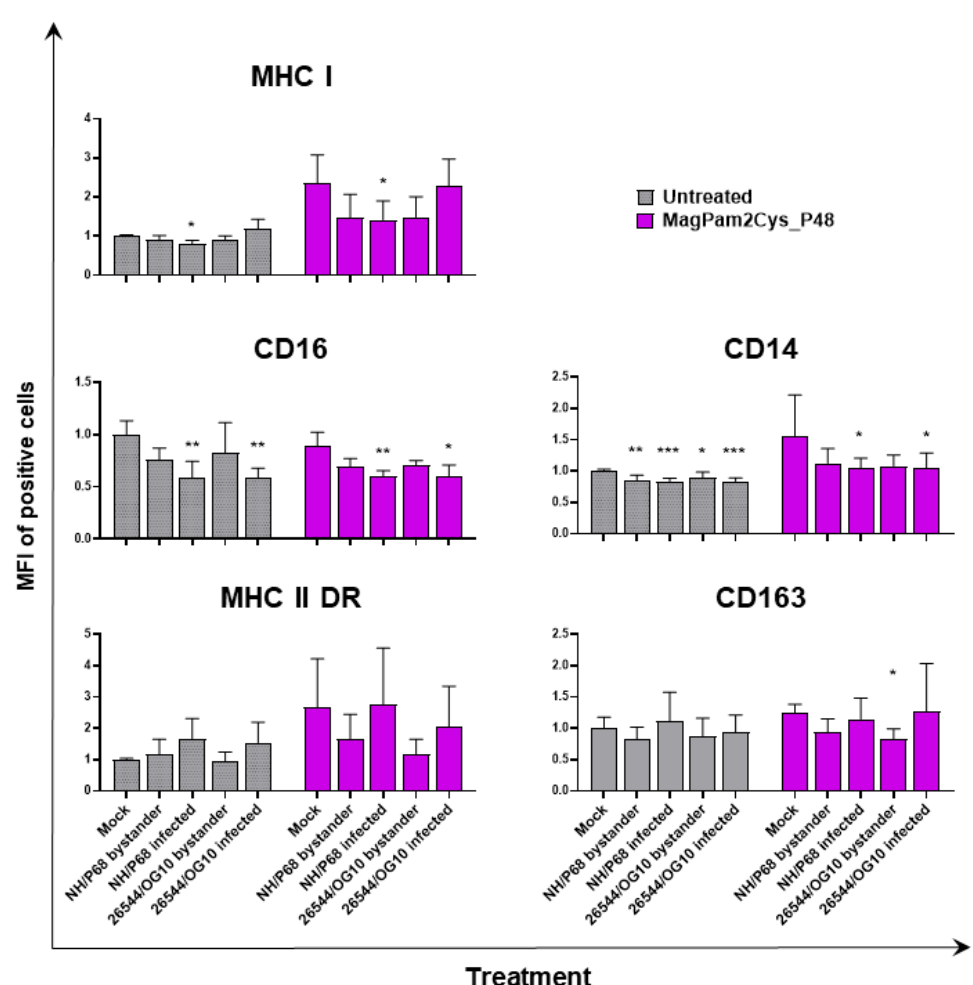
Figure 3. Impact of MagPam2Cys_P48 on ASFV-modulation of moM Φ surface marker expres- sions (mean fluorescence intensity). Porcine moM Φ were left untreated or stimulated with MagPam2Cys_P48 (100 ng/mL). Twenty-four hours later, cells were infected with either attenuated NH/P68 or virulent 26544/OG10, using a MOI of 1. Mock-infected samples were used as controls. At 21 hpi, flow cytometry was employed to determine surface expression of MHC I, CD16, CD14, MHC II DR, and CD163, and intracellular levels of ASFV late protein p72. The mean data + SD from three independent experiments utilizing different blood donors are displayed. For each marker, mean fluorescence intensity (MFI) of positive cells are presented and data are expressed as a fold change relative to the mock-infected un-activated condition (moM Φ mock). Values of ASFV-infected or bystander cells were compared to the corresponding mock-infected control using a one-way ANOVA followed by Dunnett’s multiple comparison test or a Kruskal–Wallis test followed by Dunn’s multiple comparison test; *** p < 0.001, ** p < 0.01, * p <